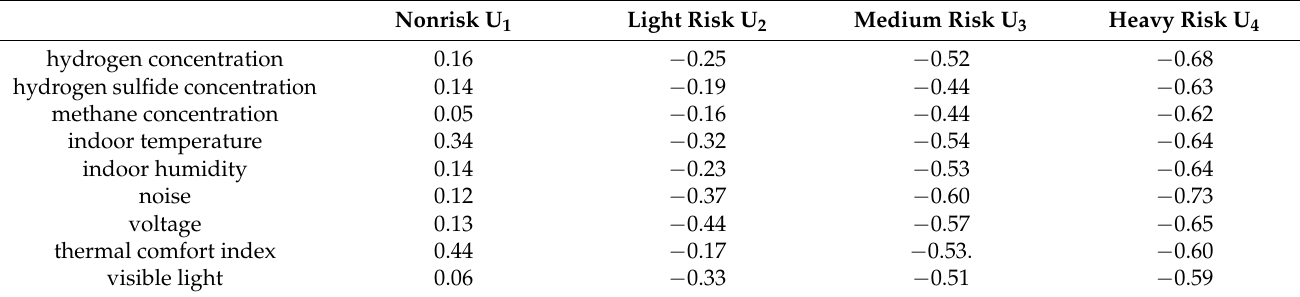
Table 6. Correlation degree of indoor safety and environmental indexes.